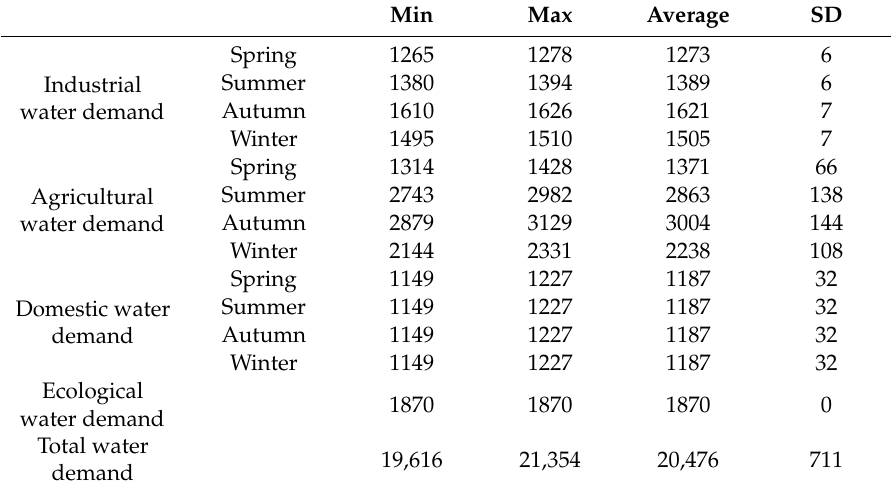
Table 4. Water demand in Henan Province in 2050 among four scenarios (100 thousand m 3